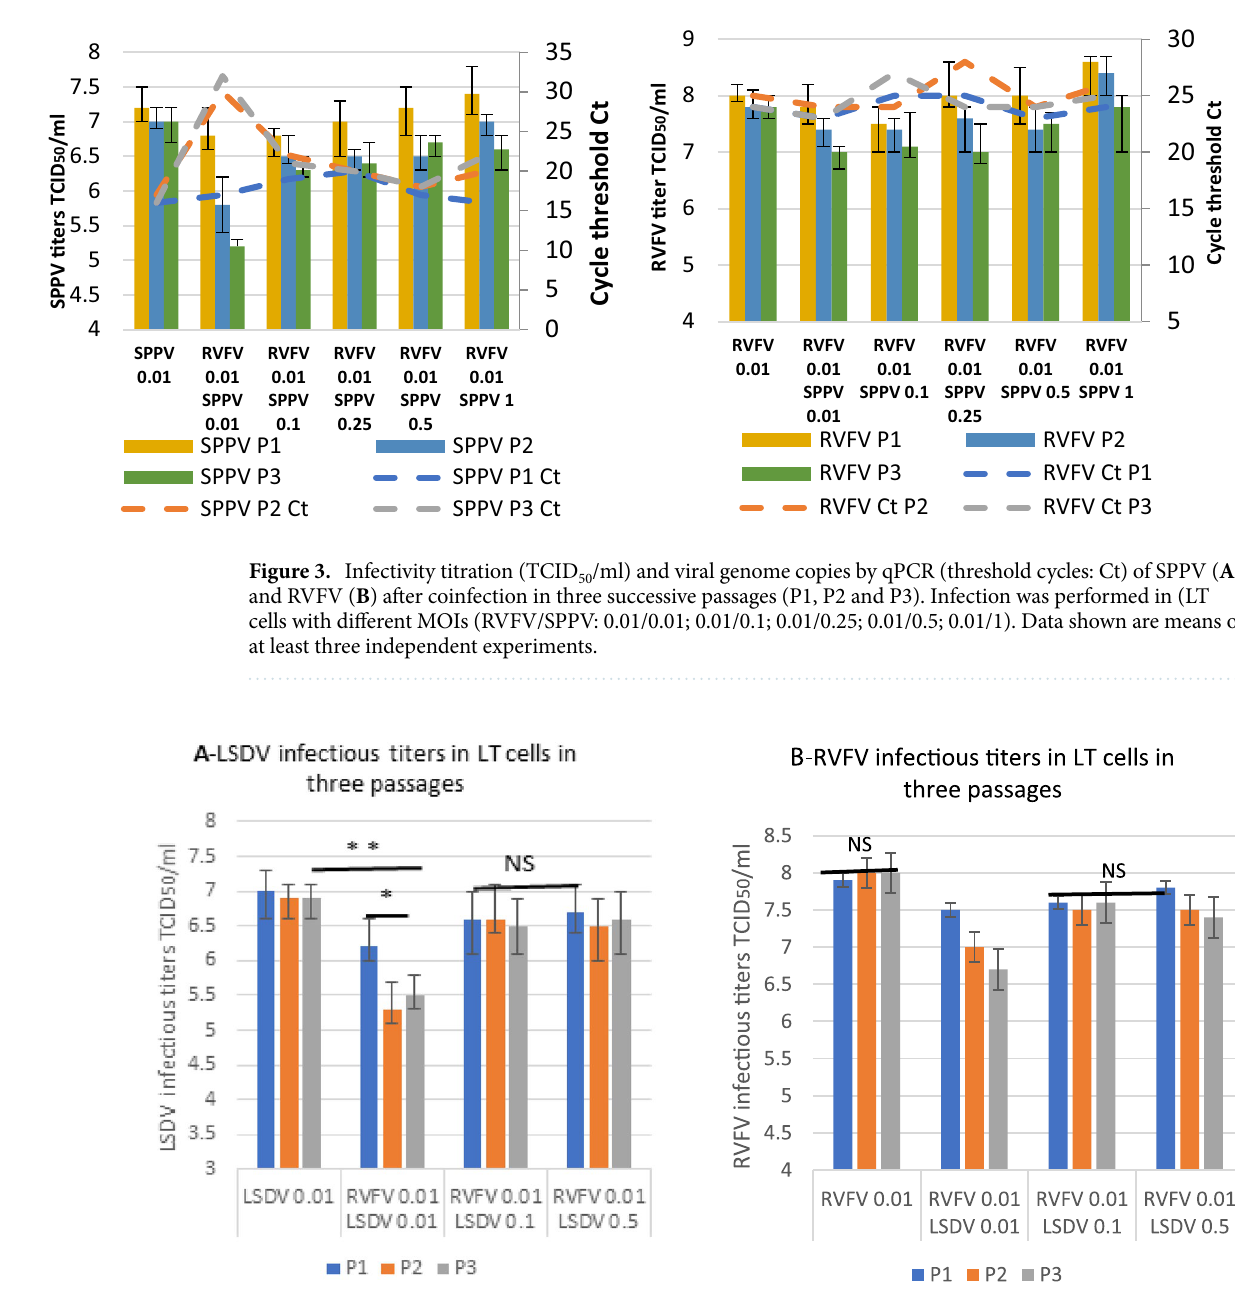
Figure 4. Infectivity titration (TCID 50 /ml) of LSDV (A) and RVFV (B) alone and after coinfection involving three successive passages (P1, P2 and P3) in LT cells. LSDV and RVFV alone at MOI = 0.01; and coinfection at different MOIs: RVFV/LSDV:0.01/0.01; 0.01/0.1 and 0.01/0.5. Data shown are means of at least three independent experiments (n = 3). NS: not significant. * statistically significant p <